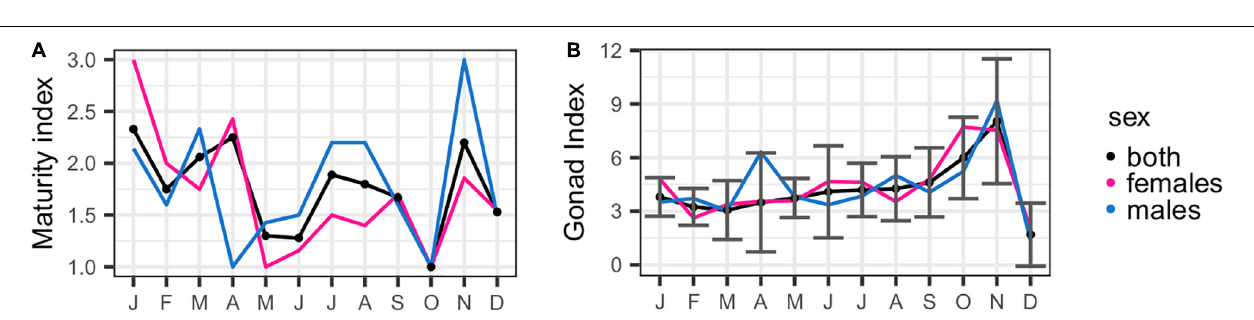
The gonads of S. granularis presented a relatively high content of total carotenoids (average 296.36 ± 213.24 µ g/g DM), significantly affected by the interaction of factors season and sex